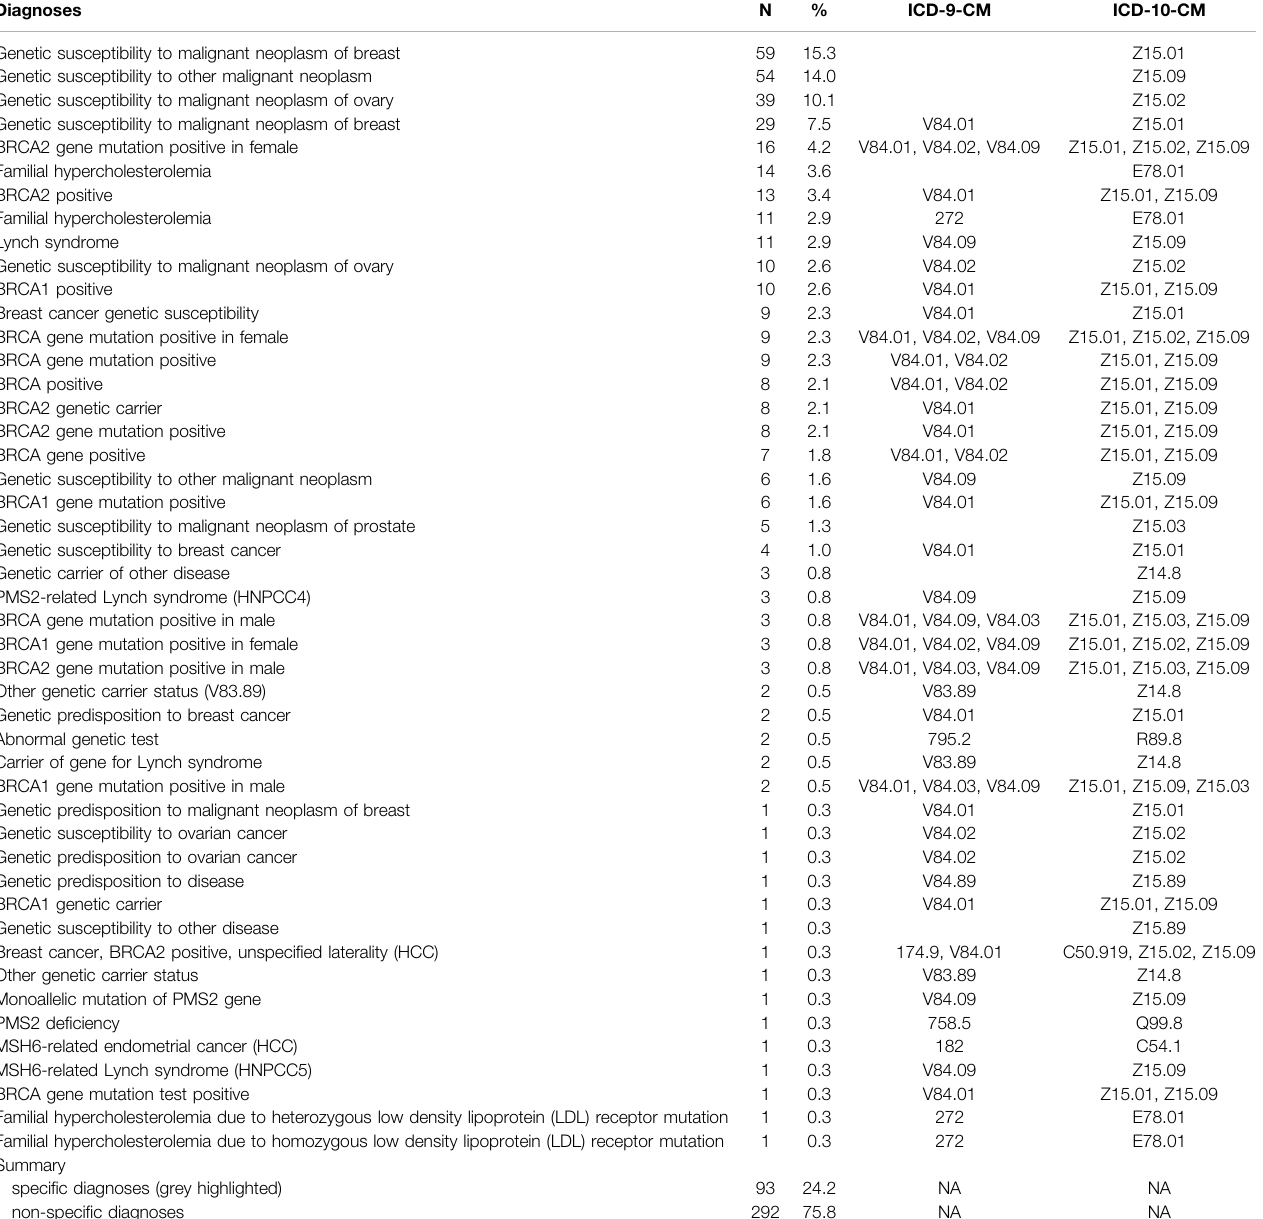
TABLE 2 | Relative abundance of unique diagnoses appearing in participant EHRs. Shaded diagnoses are considered to be suf fi ciently speci fi c for clinical purposes. Diagnoses